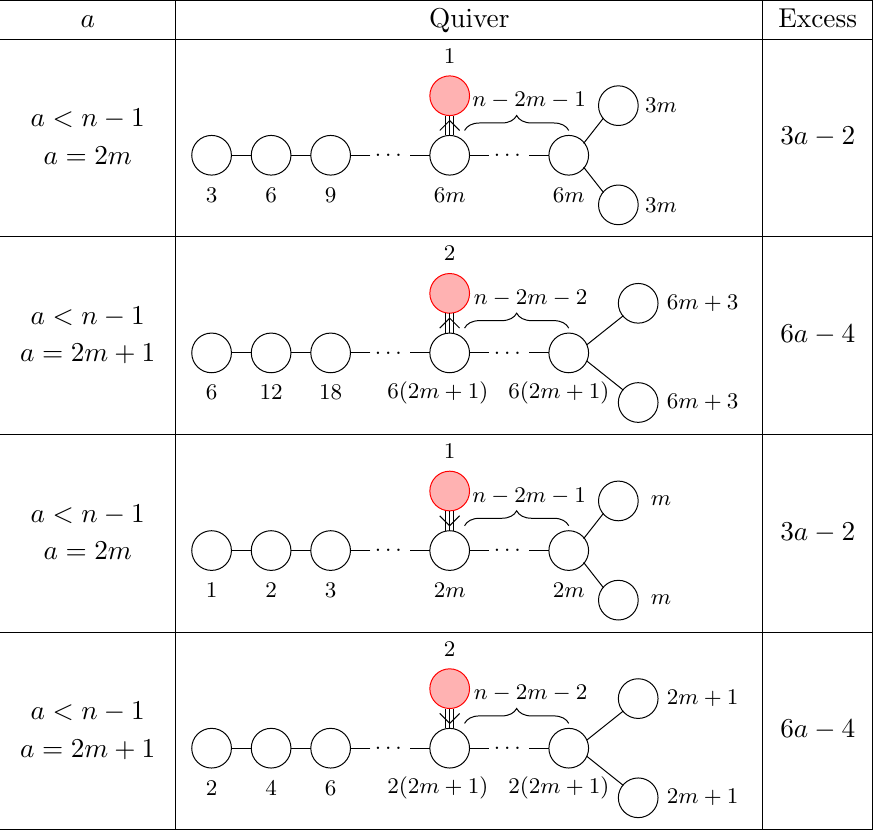
Table 16 . Exotic minimally unbalanced quivers with G = SO(2 n ) and a triple laced